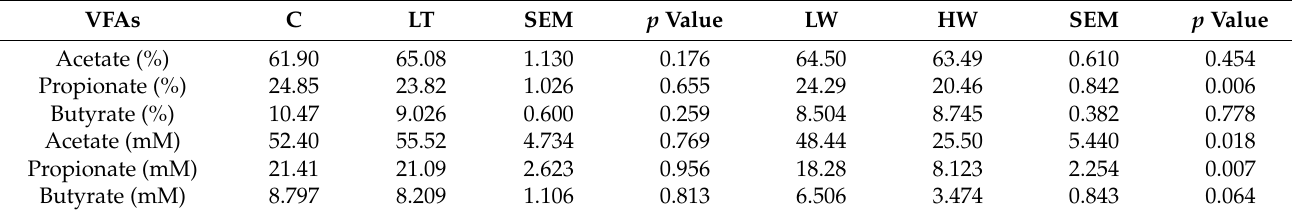
Figure 1. Effect of low temperature on the growth index of sheep. ( a , d ) Average daily gain (ADG) changes in sheep. ( b , e ) Dry matter intake (DMI) of each group of sheep. ( c , f ) Crude fiber (CF) in stool. C, sheep exposed to 5 °C, and LT, sheep exposed to − 15 °C; LW, sheep exposed to − 15 °C and an average wind velocity of 3 m/s, and HW, sheep exposed to − 15 °C and an average wind velocity of 5 m/s. *, p < 0.05; **, p < 0.01. Table 1. The proportion of volatile fatty acids (VFAs) in the rumen under the cold stress.